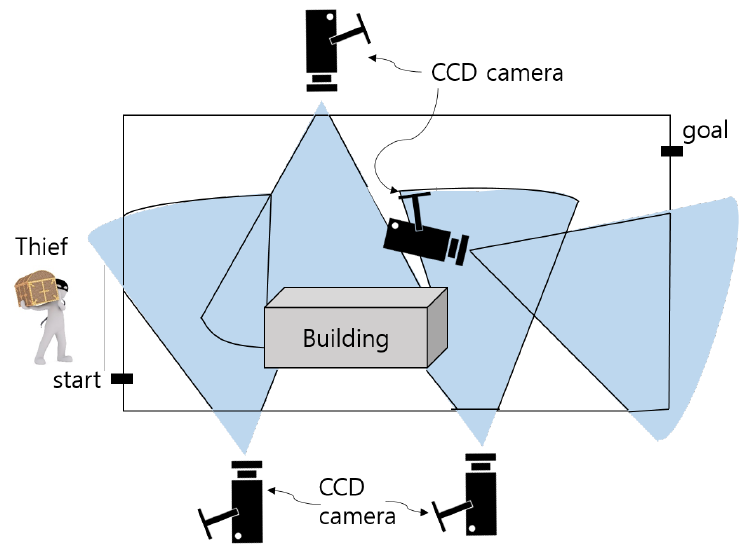
Figure 2. Sensing areas from an arrangement of CCD cameras (blue cones) and a building (gray cuboid). The sensitivity potential function for a sensor s ∈ S is assumed to have the following general